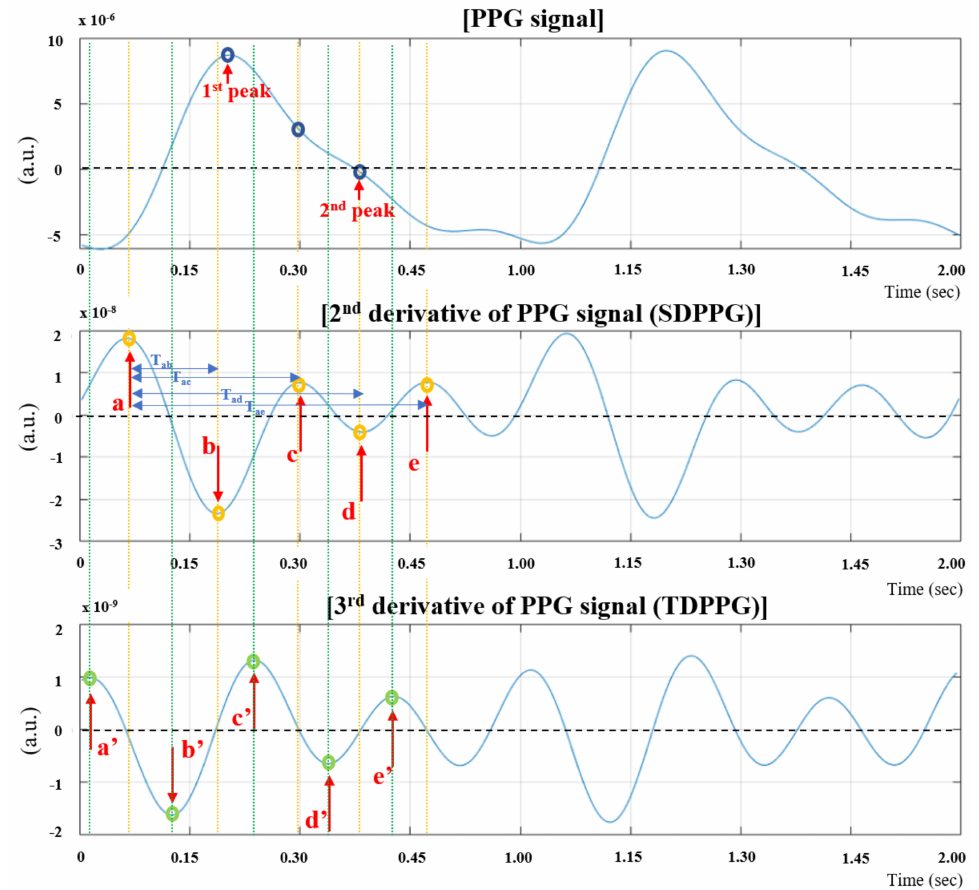
Figure 2. Description of PPG, SDPPG, and TDPPG